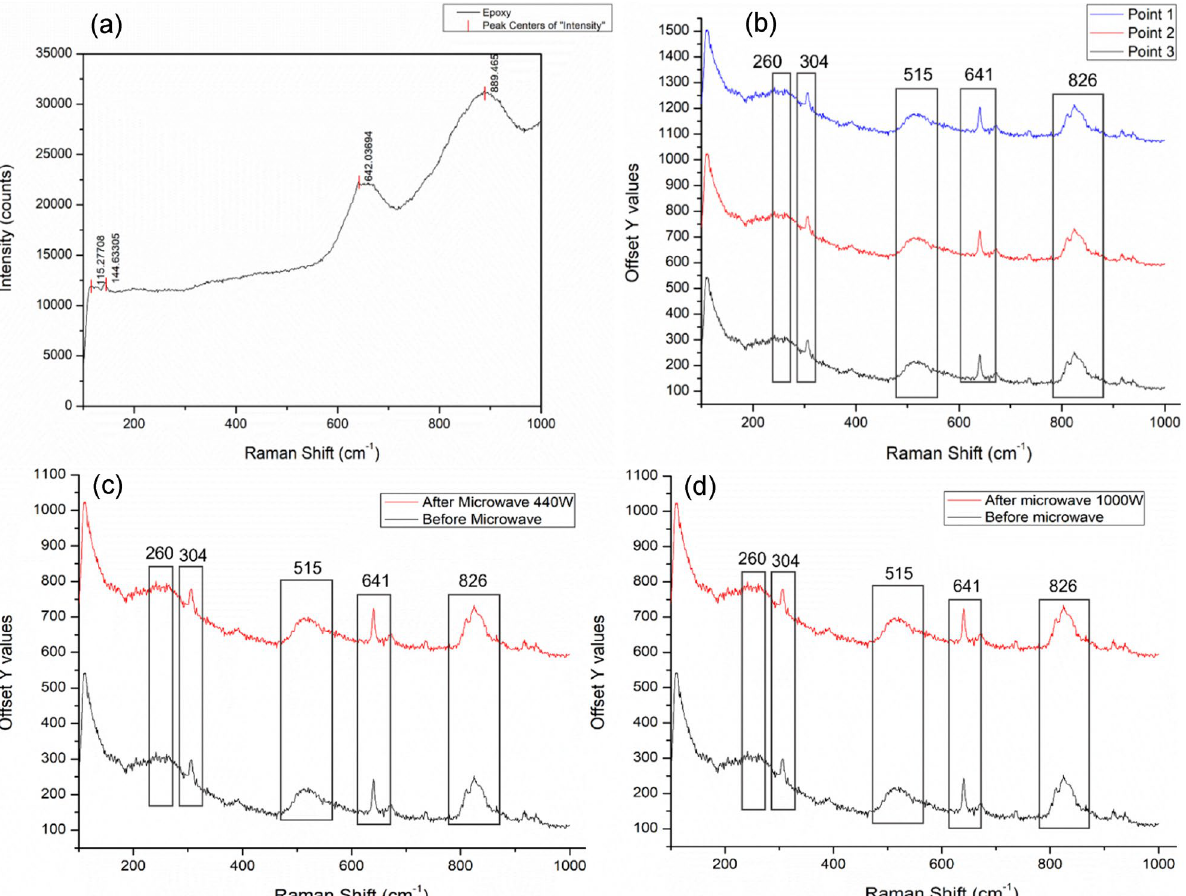
Figure 27. Raman spectra of ( a ) neat epoxy, ( b ) three random points of 15 wt.% epoxy nanocomposites with Si-BaTiO 3 before microwave exposure, ( c ) 15 wt.% epoxy nanocomposites with Si-BaTiO 3 before and after microwave exposure of 440 W for 150 s ( d ) 15 wt.% epoxy nanocomposites with Si-BaTiO 3 before and after microwave exposure of 1000 W for 60